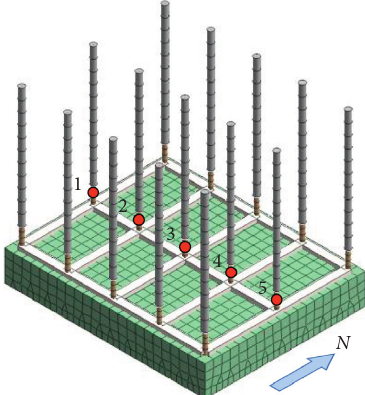
Figure 23: Schematic map of measuring